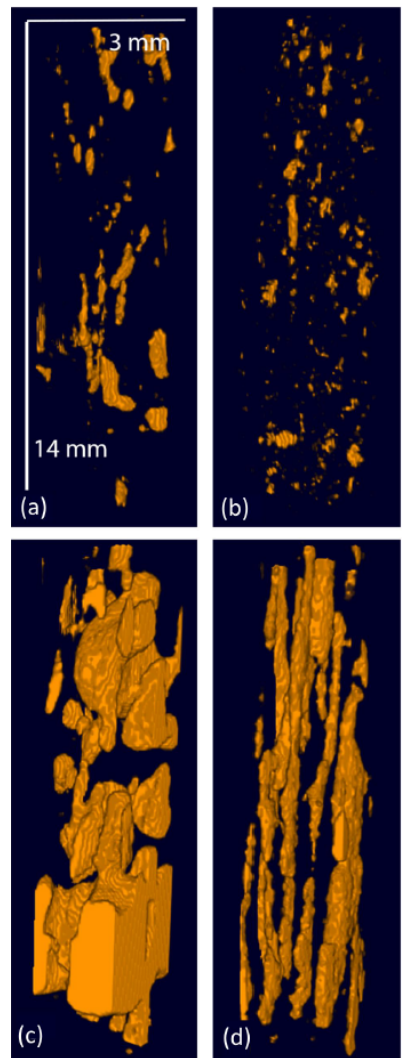
Figure 2. Three-dimensional images derived using X-ray CT tech- niques, showing subvolumes of the entire sample. (a) March 2013: 0.20–0.26m (granular ice). (b) March 2013: 0.88–0.94m (colum- nar ice). (c) June 2013: 0.20–0.26m. (d) June 2013: